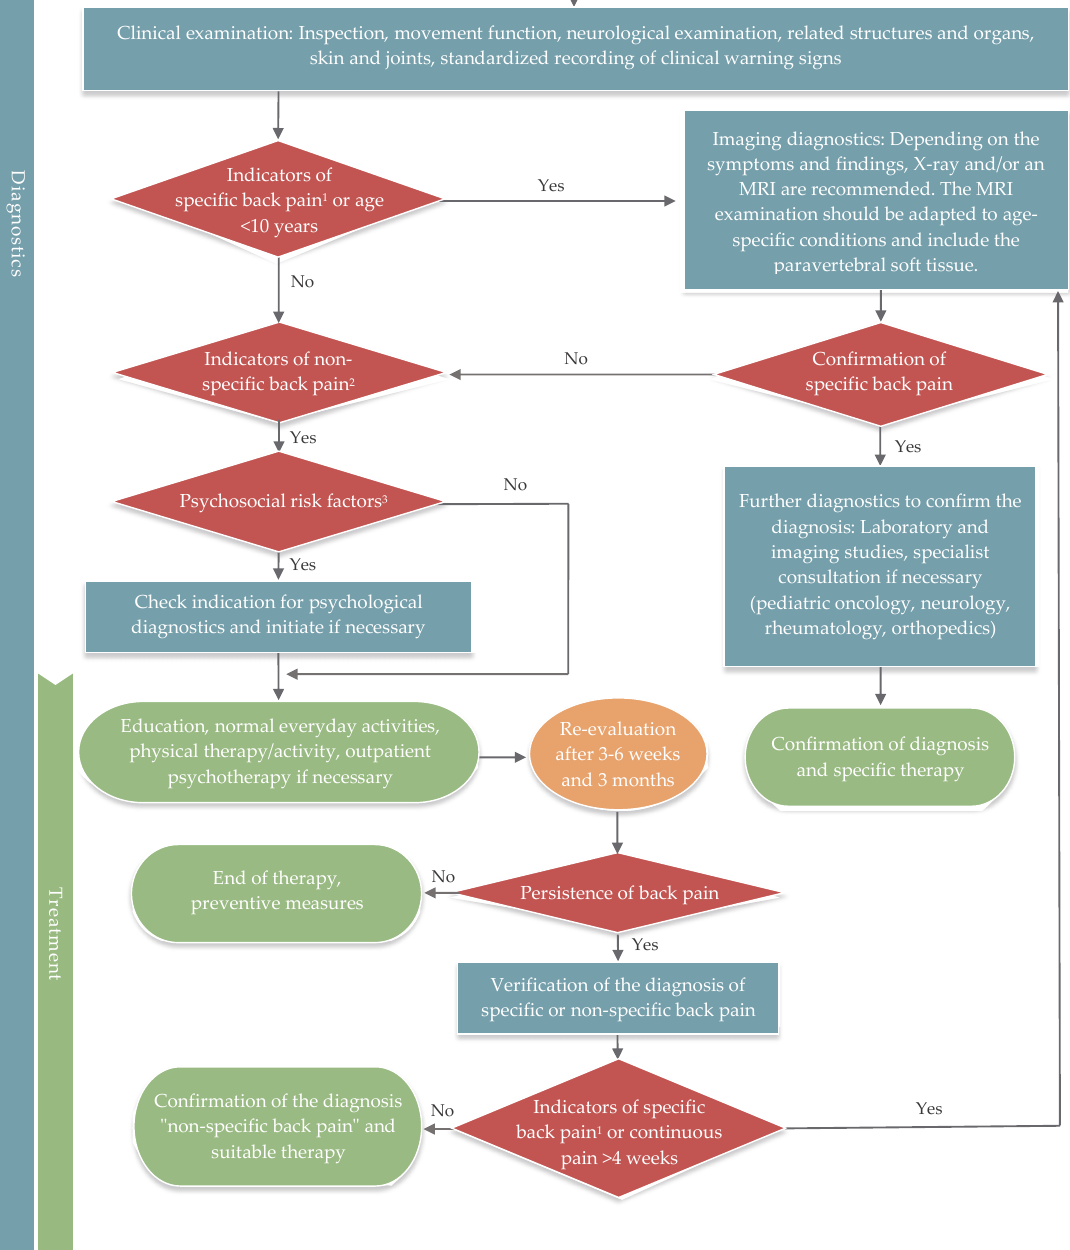
Figure 2. Diagnostic algorithm for back pain in children and adolescents. Green box = treatment; blue box = diagnostic measures; red box = diagnostic decision. 1 Red flags for specific back pain (Chapter 3.1.1, Table 1), 2 Risk factors for non-specific back pain (Chapter 3.1.2, Table 2), 3 Low life satisfaction, anxiety, depression, low self-esteem (see Table